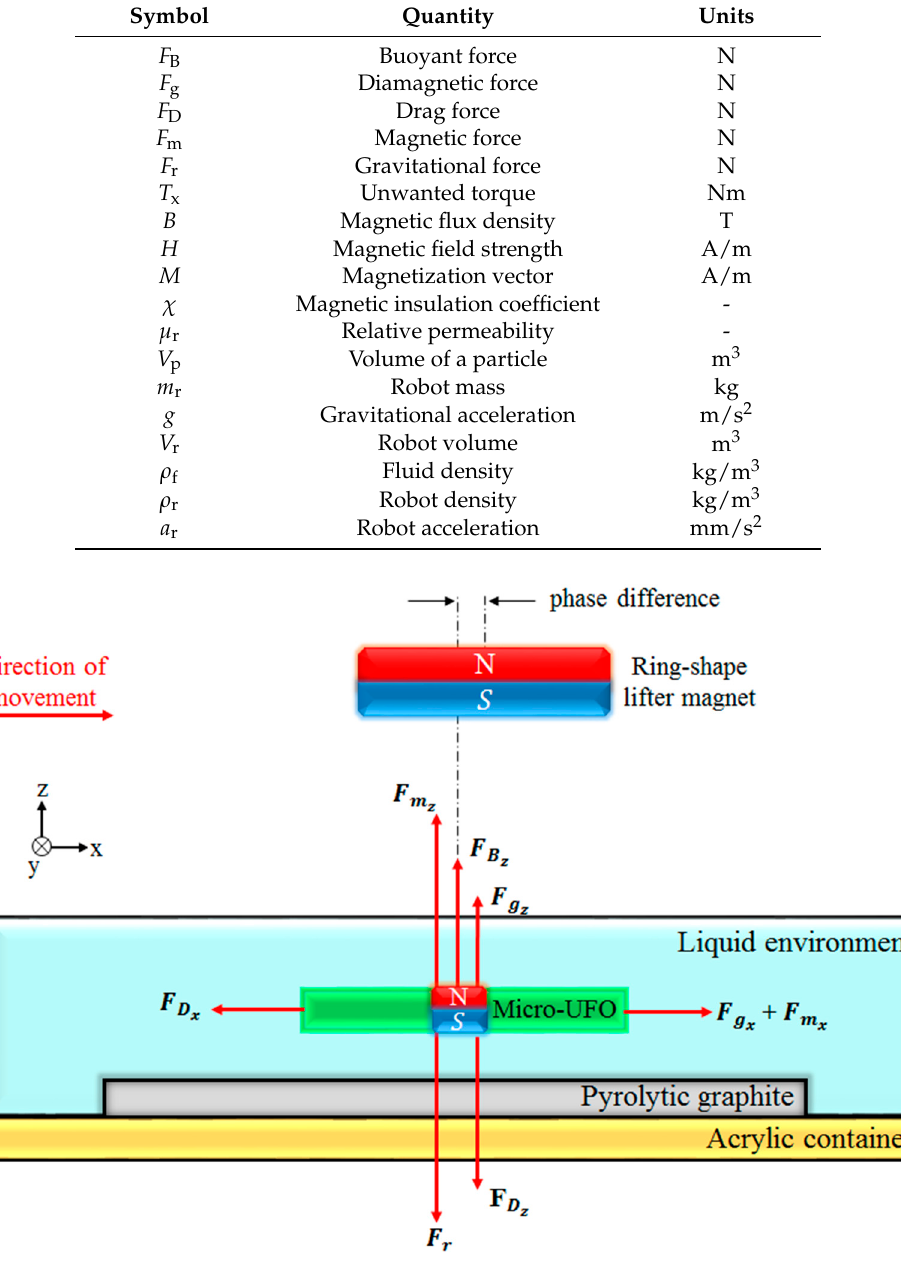
Figure 1. Shows the forces acting on the micro-untethered floating object (micro-UFO) during the z -axis levitation and lateral movement along the x -axis. The phase difference that occurs in the lateral movements is expressed as the distance between the center of the lifter and the carrier magnet.